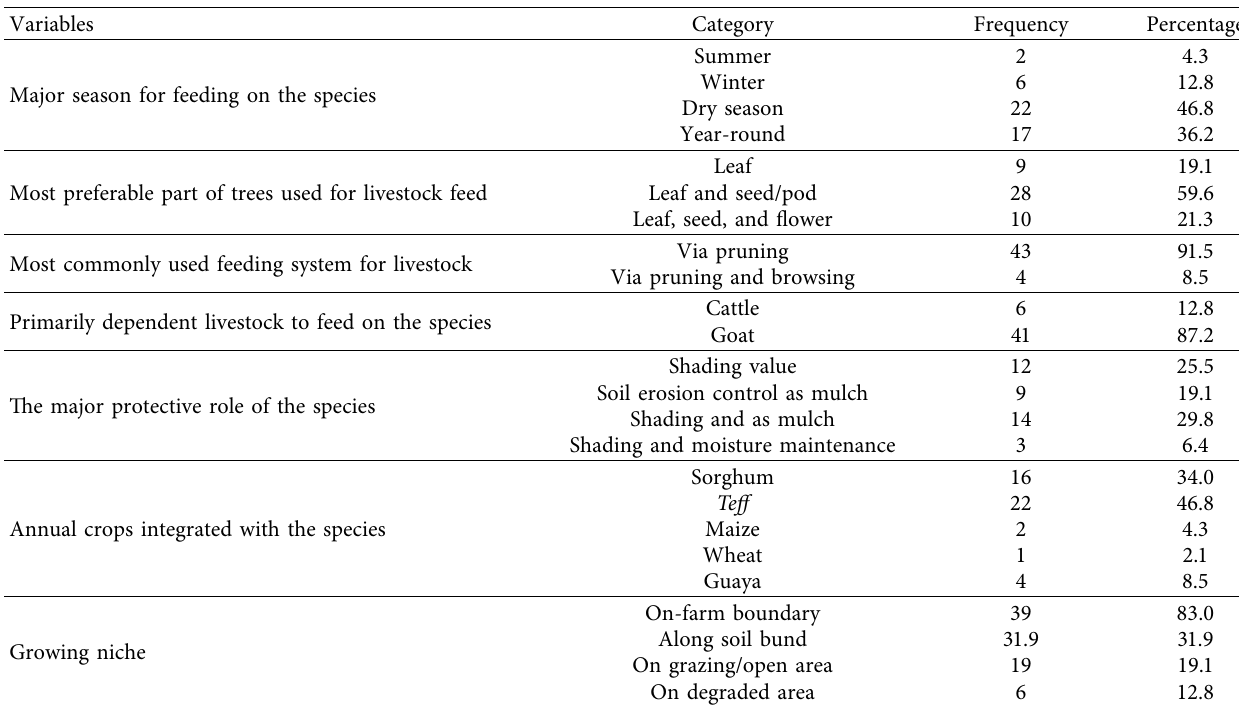
Table 9: Farmers’ response on feeding system, integrated management, and preferred growing niche for Acacia seyal